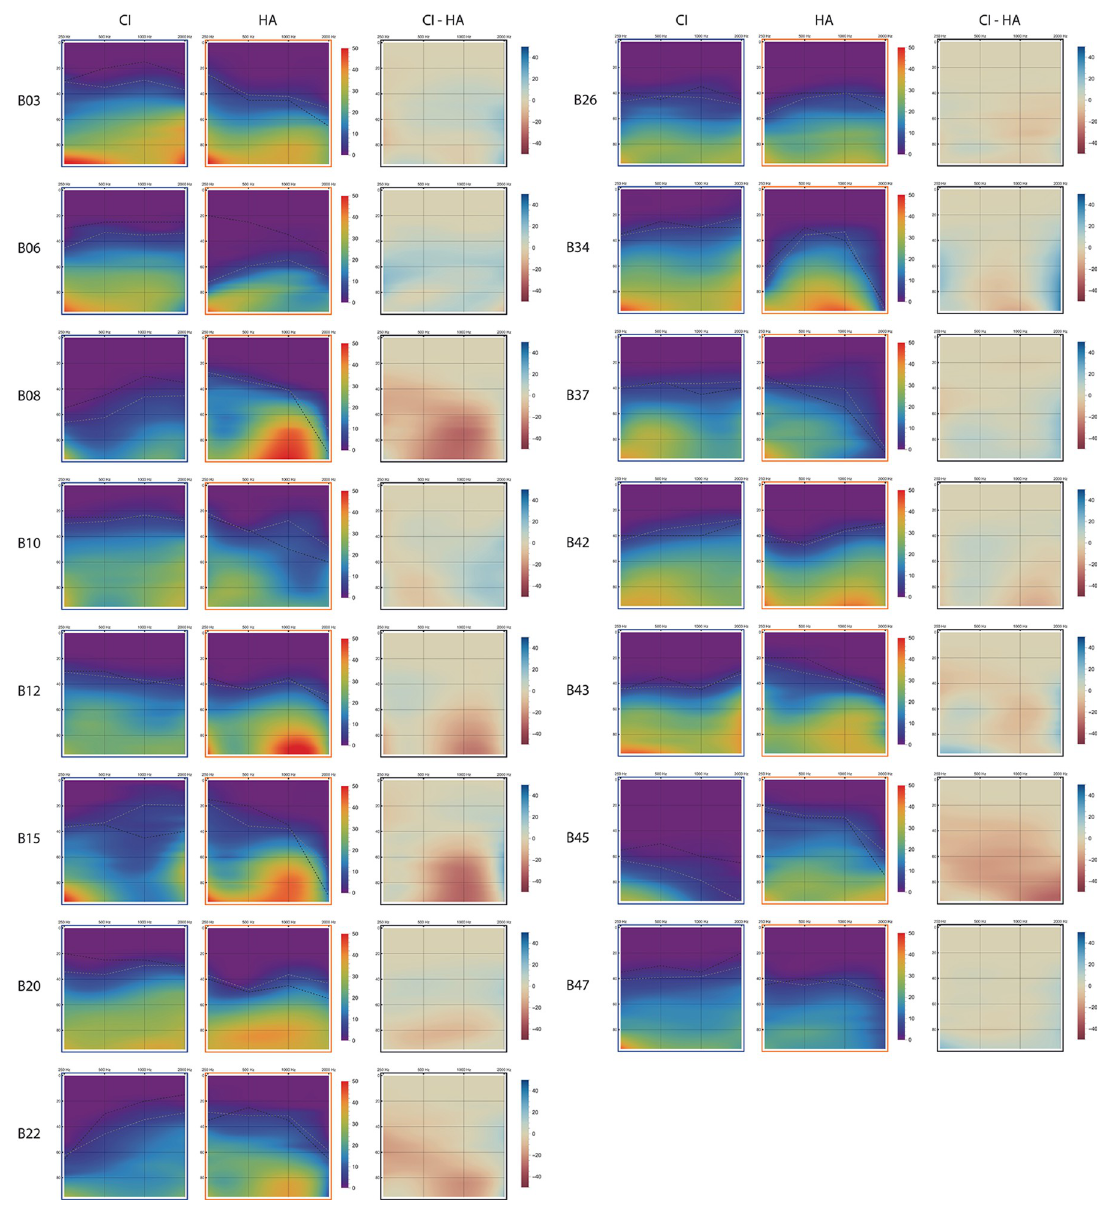
Fig 3. Loudness audiograms for all conditions (CI (blue frame), HA (orange frame) and CI minus HA (black frame). Aided audiometric thresholds are projected as dashed black lines and estimated ACALOS thresholds (T5CU) as gray lines.